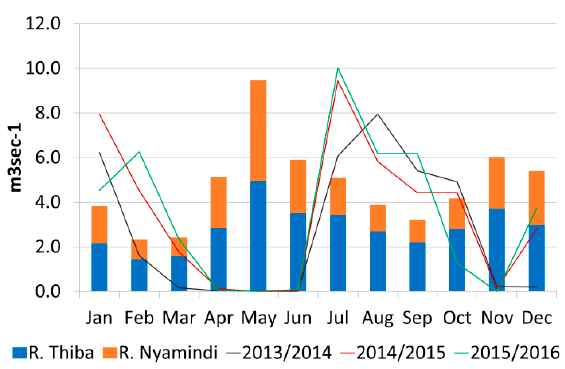
Figure 7. Comparison of total available flow (historical simulation) with water demand (2013–2016).